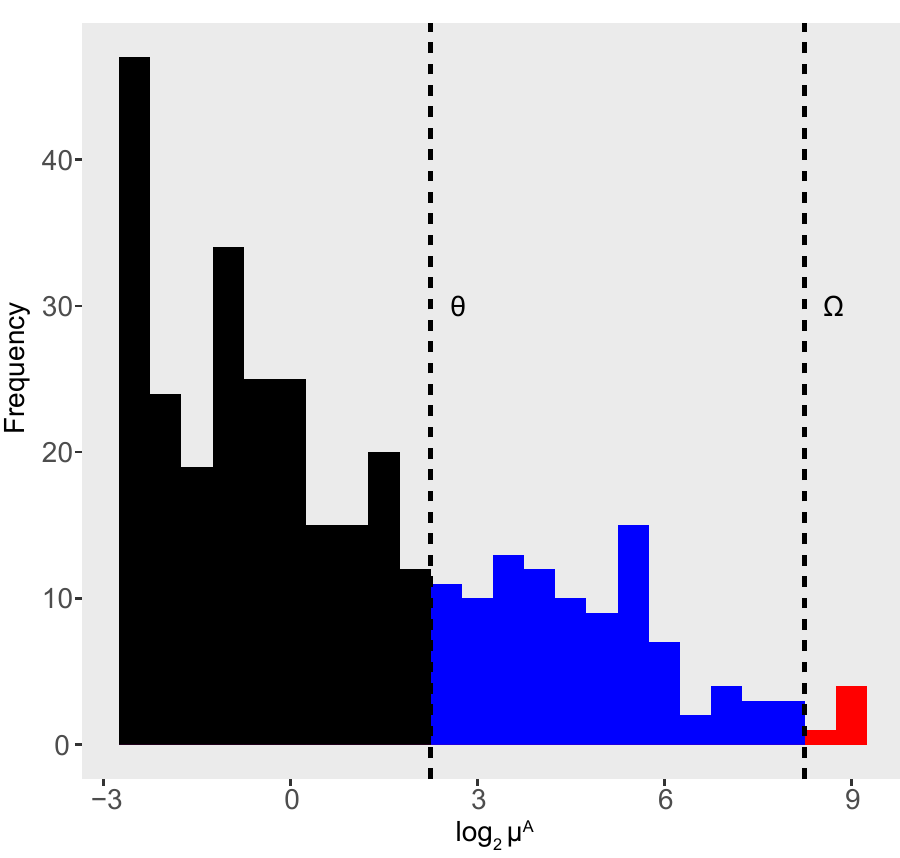
Fig 2. Distribution of mean abundance in log scale for the tooth dataset. The dotted lines identify the abundance levels limits for sampling the DA features: low (in black), medium (in blue) and high (in red).